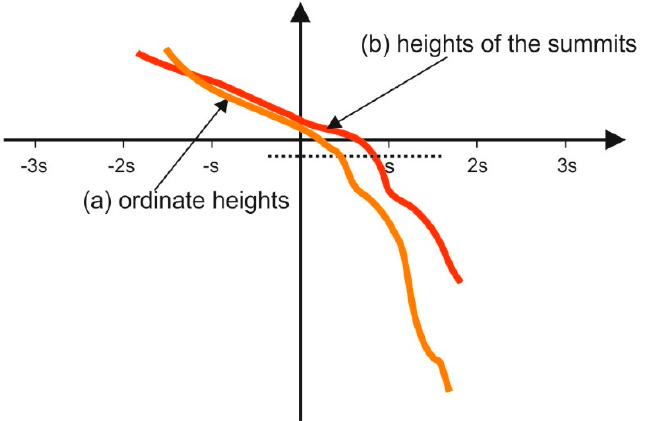
Figure 16. Cumulative probability distribution of the ordinate heights (a) and the heights of the summits (b), adapted from [165].